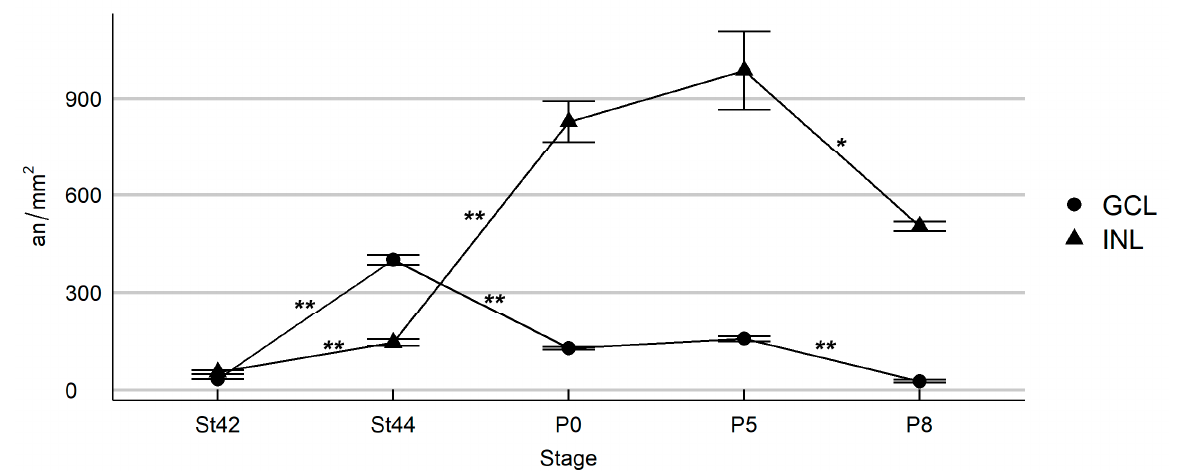
Figure 6. Quantitative analysis of the density of TUNEL-positive nuclei during T. guttata retinal histogenesis. The incidence of cell death rose significantly in the GCL between St42 and St44, reaching the highest values in this layer by this latter stage. From P0 onwards, the density of TUNEL-positive nuclei in the GCL diminished progressively. The INL contained a low density of TUNEL-positive nuclei between St42 and St44. A significant increase in the density of TUNEL-positive nuclei was observed at P0, reaching a maximum at P5. At P8, there was a high incidence of cell death in the INL. Abbreviations: an/mm 2 , apoptotic nuclei per square millimeter; GCL, ganglion cell layer; INL, inner nuclear layer. Asterisks correspond to p values; * p < 0.05 and ** p <